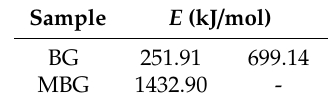
Table 6. Crystallization activation energy ( E ) of the BG and MBG at di ff erent temperatures. Sample